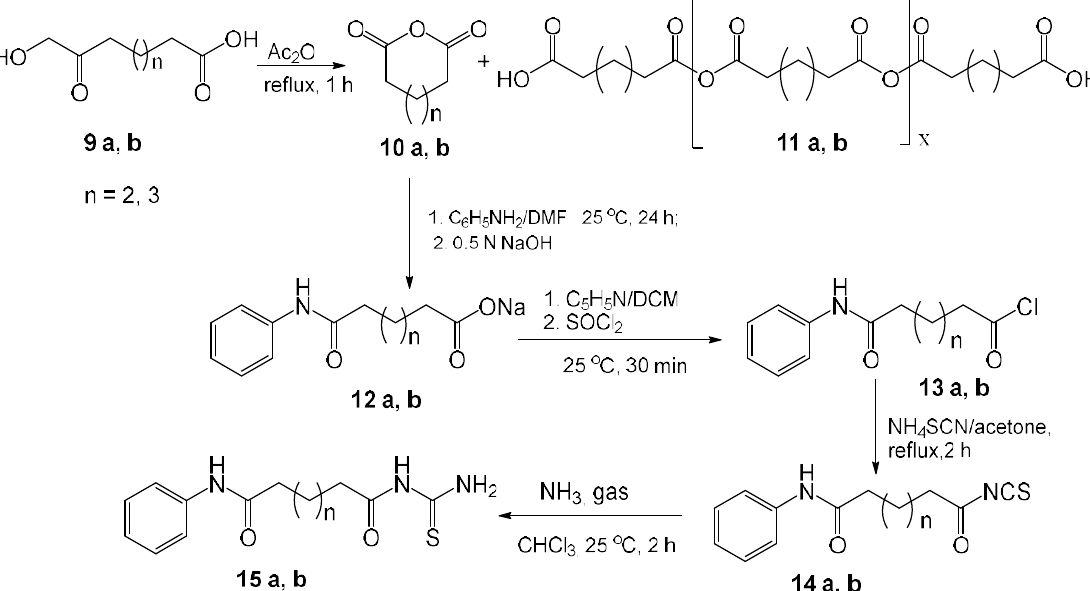
Fig. 3. Approaches to the synthesis of N -[(2-cyano-4-nitrophenyl)carbamothioyl]acylamides